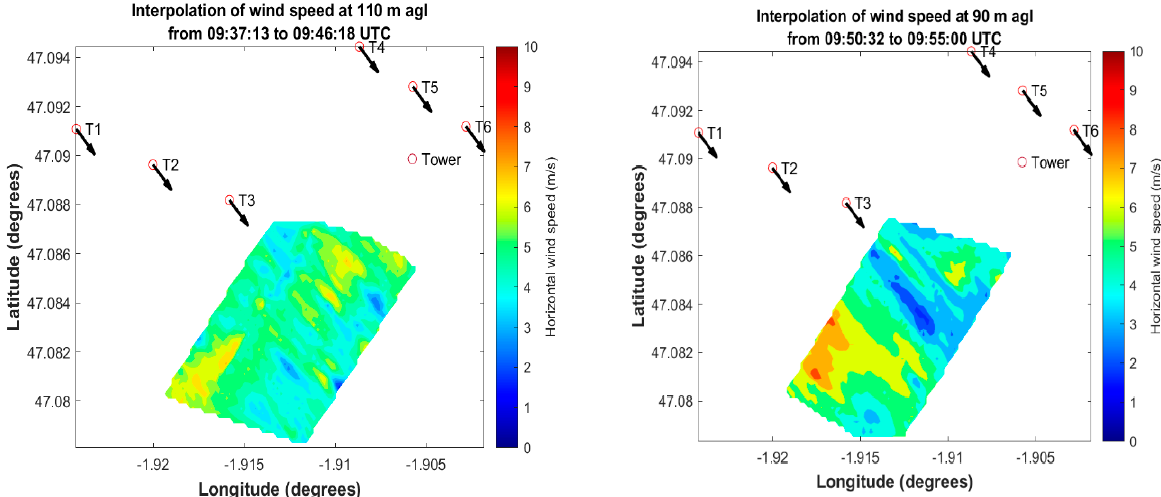
Figure 11. 2-D fields of the horizontal wind speed measured on 28 April when all the wind turbines were operating. Left plot : at 110 m (agl). Right plot : at 90 m (agl). The black arrows represent the wind direction average during this specific flight phase. T1 to T6 are the localizations of the six wind